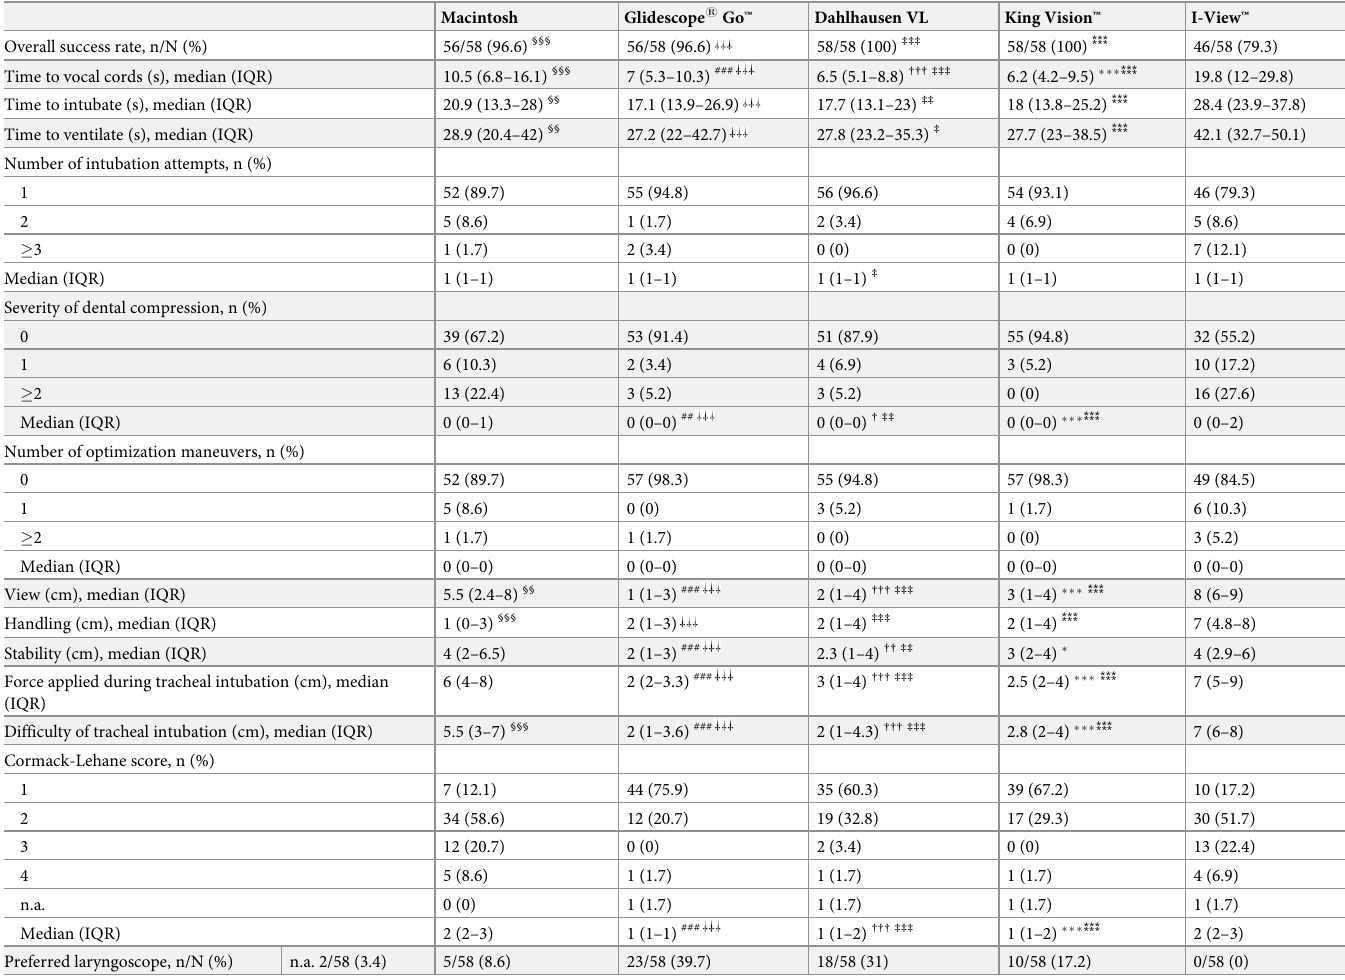
Table 2. Intubation data of anesthetists with extensive previous experience in conventional and video